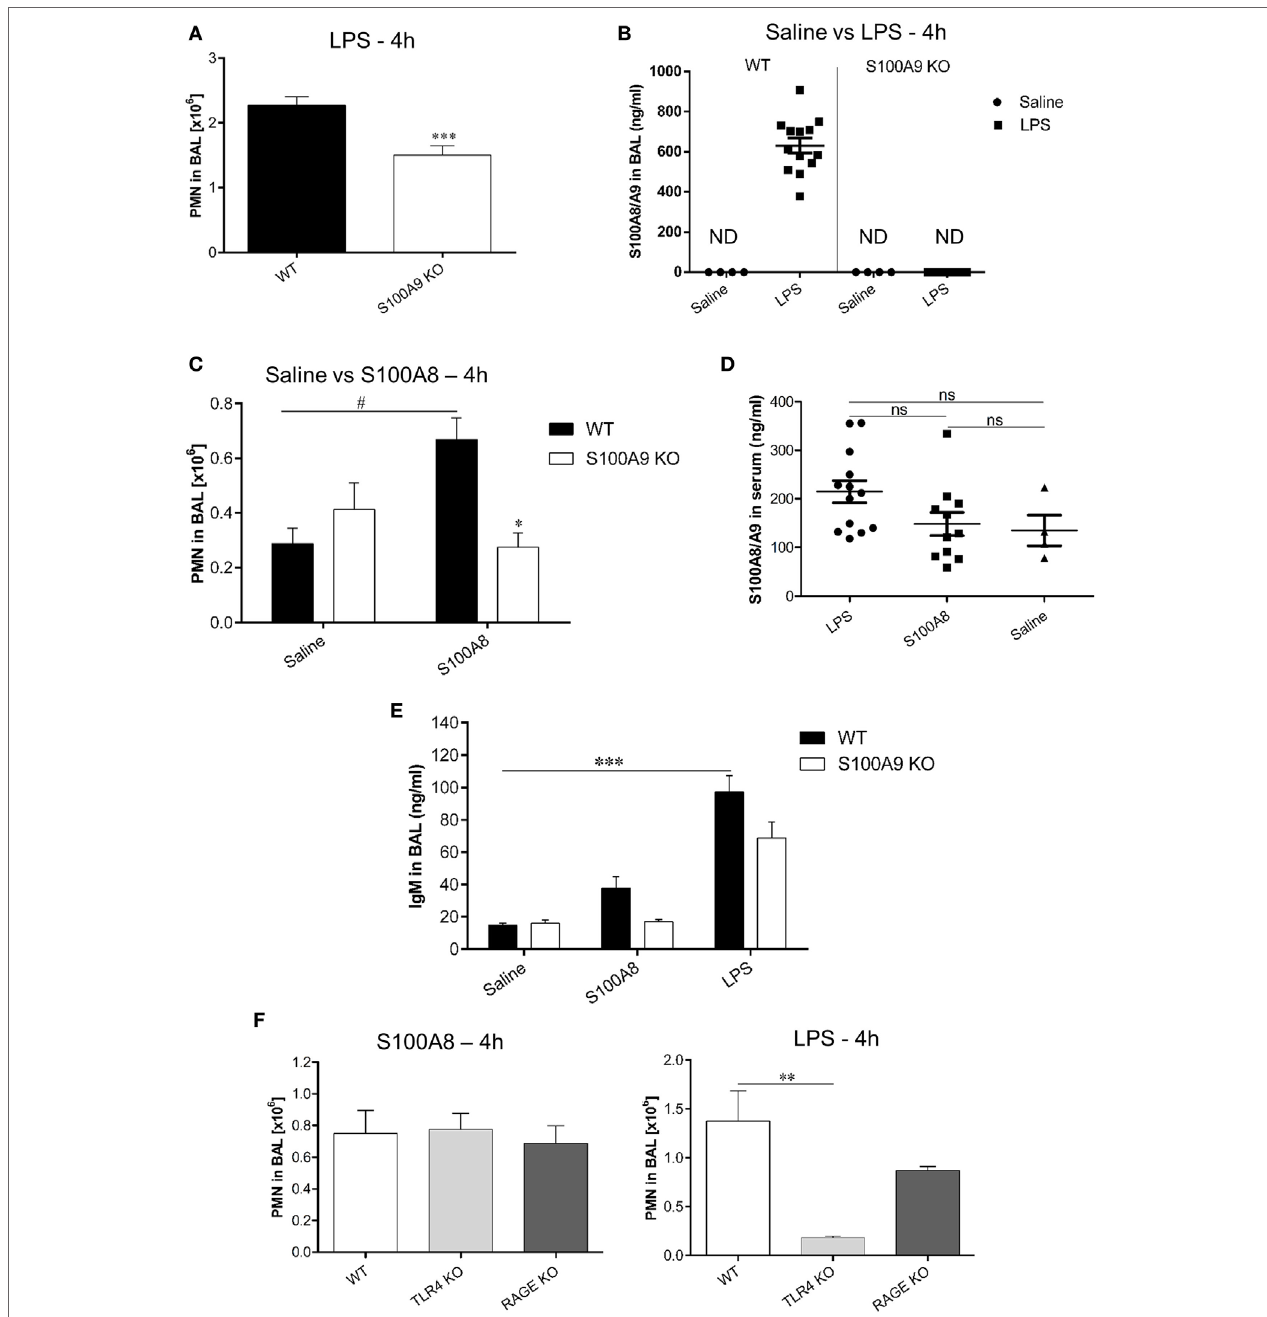
FigUre 6 | Comparison of polymorphonuclear neutrophil (PMN) recruitment and S100A8/A9 release in BAL and serum of WT and S100A9 KO mice exposed to lipopolysaccharide (LPS) or S100A8. (a) WT and S100A9 KO mice were exposed to LPS and PMN were counted in BAL after 4 h. Data are expressed as mean ± SEM ( n = 11 mice per group). *** p < 0.001 compared to WT mice. (B) S100A8/A9 release was analyzed by enzyme linked immunosorbent assay (ELISA) in the BAL of WT or S100A9 KO mice 4 h after saline or LPS inhalation. Data are expressed as mean ± SEM ( n ≥ 10 mice per group for LPS and n = 4 mice per group for saline). ND, not detectable. (c) WT and S100A9 KO mice were exposed to saline or murine S100A8 and PMN were counted in BAL after 4 h of exposure. Data are expressed as mean ± SEM ( n = 4 mice per group for saline and n = 6 mice per group for S100A8). * p < 0.01 compared to S100A8 exposed WT mice. # p < 0.01 compared to saline exposed WT mice. (D) S100A8/A9 release was analyzed by ELISA in serum of WT mice exposed to LPS or S100A8 or saline. Data are expressed as mean ± SEM ( n = 13 mice per group for LPS, n = 11 mice per group for S100A8, and n = 4 mice per group for saline exposure). ns, non-significant. (e) IgM release was analyzed by ELISA in BAL of WT and S100A9 KO mice 4 h after exposure to saline or murine S100A8 or LPS. Data are expressed as mean ± SEM ( n = 4 mice per group for saline, n = 5 mice per group for S100A8, and n = 10 mice per group for LPS). *** p < 0.001compared to saline exposed WT mice. (F) WT, TLR4 KO, and RAGE KO mice were exposed to murine S100A8 or LPS and PMN were counted in BAL after 4 h of exposure. Data are expressed as mean ± SEM ( n = 4 mice per group for LPS and S100A8). ** p < 0.01 compared to WT